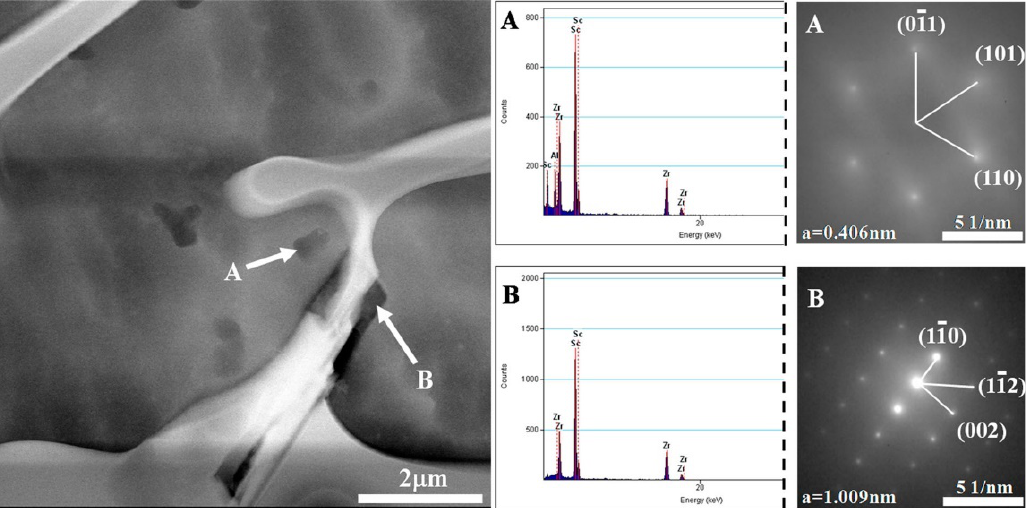
Figure 9. TEM image of the as-cast Be–Al–Sc–Zr alloy with corresponding EDS and SAD patterns of phases ( A , B ) [45]. Reprinted/adapted with permission from Ref. [45]. Copyright 2018, Taylor & Francis Ltd.